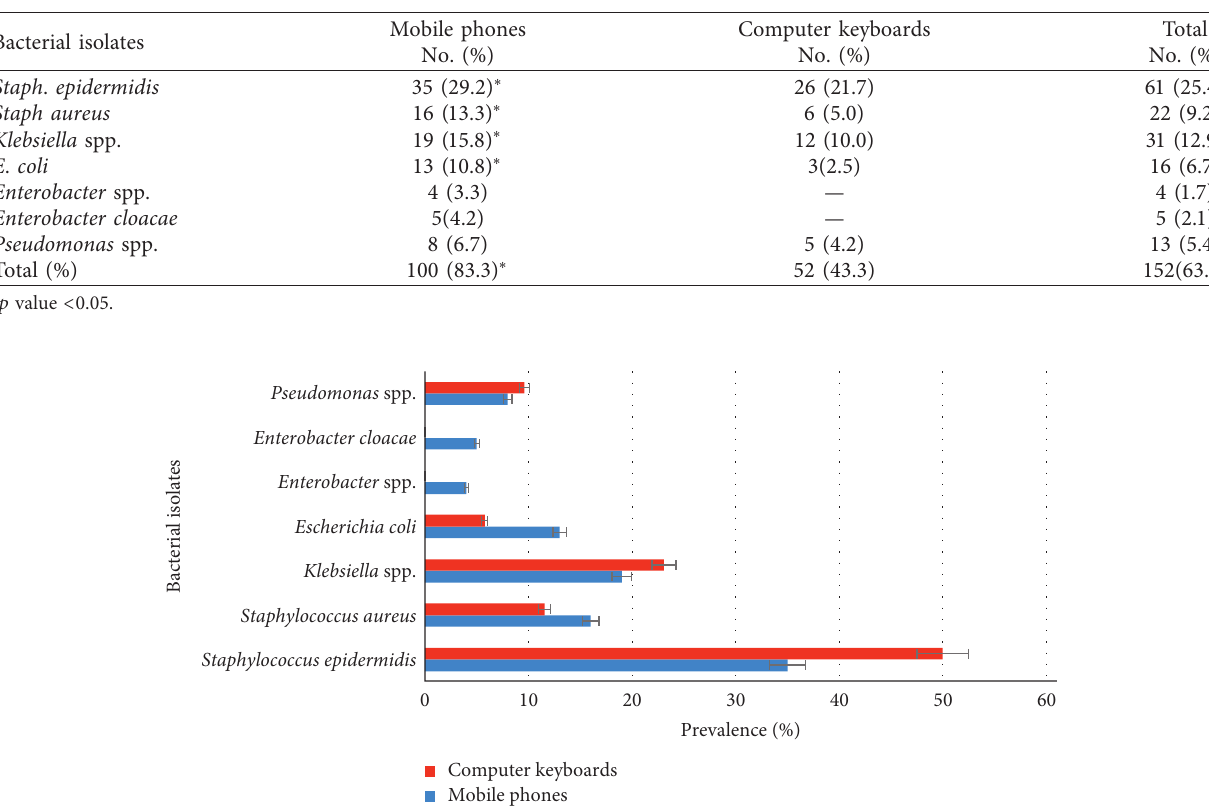
Table 1: Prevalence of bacteria isolated from mobile phones and computer keyboards.